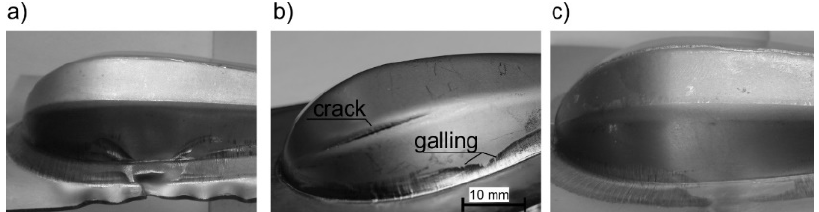
Figure 7. Results of forming: ( a ) with no blank holder—visible wrinkling, ( b ) with blank holder in